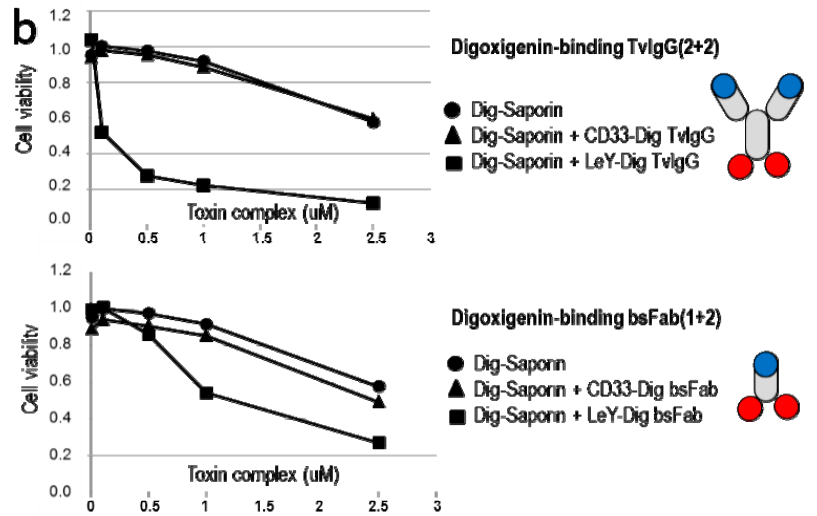
Figure 3. TriFab mediated targeted delivery of a large molecule. The applied bsAb formats are schematically depicted on the right (cell targeting entities in blue, Dig-binding entities in red and Bio-binding entities in green colour). ( a ) TriFab specific for Dig and GPC3 or CD33 or LeY combined with Dig-Saporin or Bio and GPC3 or CD33 or LeY combined with Bio-Saporin were applied for targeted delivery of saporin. TriFab-Saporin complexes were generated by a simple and robust charging procedure as previously described for hapten-coupled payloads [11,13–15]: Dig-Saporin and TriFabs are incubated in a 1:1 molar ratio in cell culture medium for at least 15 min, followed by subsequent dilution to the concentrations indicated. BrdU incorporation and ATP-content (Cell Titer Glo, CTG) assays were applied to measure the viability of cells 48 h after exposure to TriFab and Saporin; ( b ) Targeted delivery of Dig-Saporin with IgG-derived (two antigen binding sites + two Dig-binding sites) or Fab-derived (one antigen binding site + two Dig-binding sites) bsAbs of the same targeting specificity indicates that TriFabs have at least the same specificity and delivery potential as other bsAb Formats (monovalent cell surface targeting with LeY specificity is less potent than bivalent (avidity-enhanced) targeting).